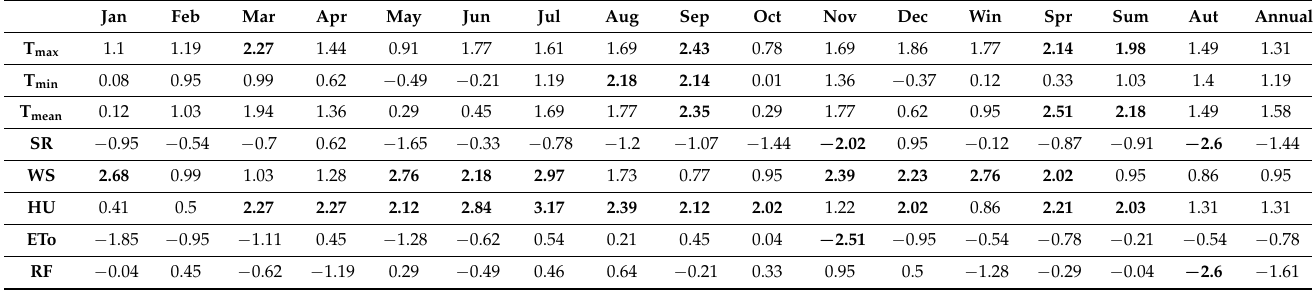
Table 2. MK trend test result with 95% significance level.